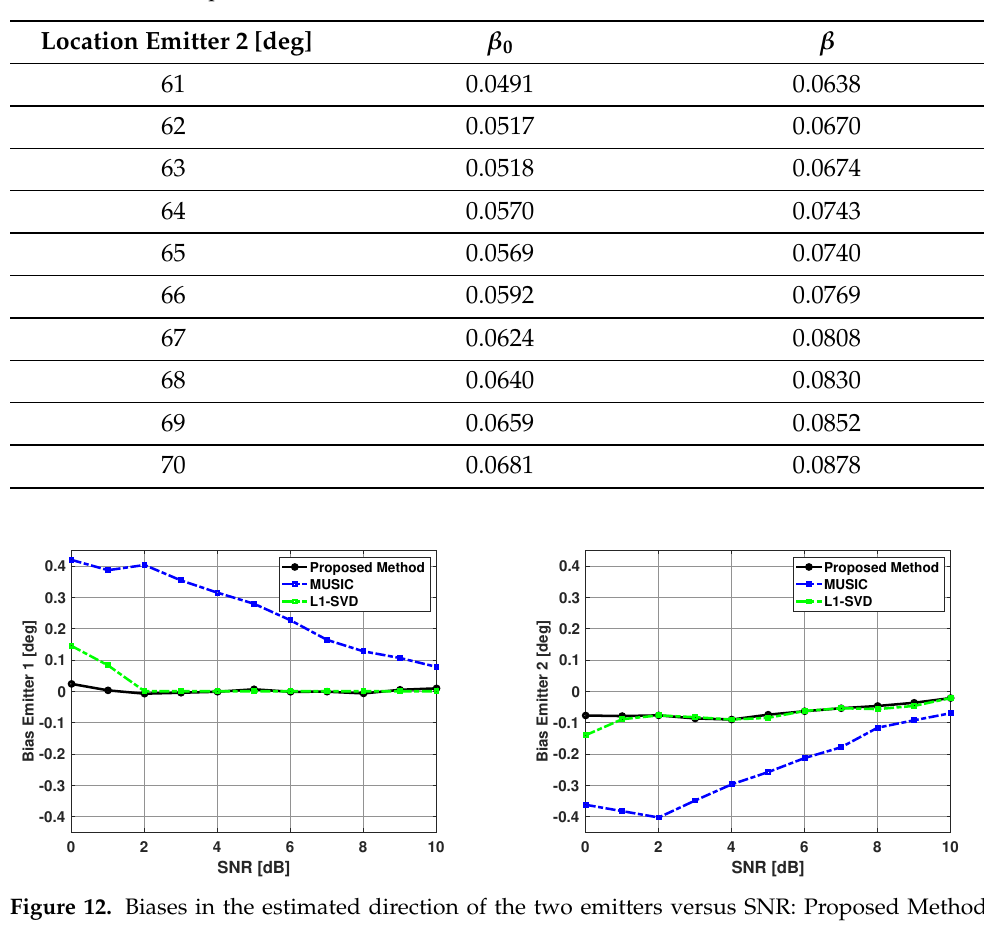
Table 2. Average β 0 and selected β value over 500 Trials with Respect to Emitter 2 Location. SNR = 5 dB, 100 snapshots.